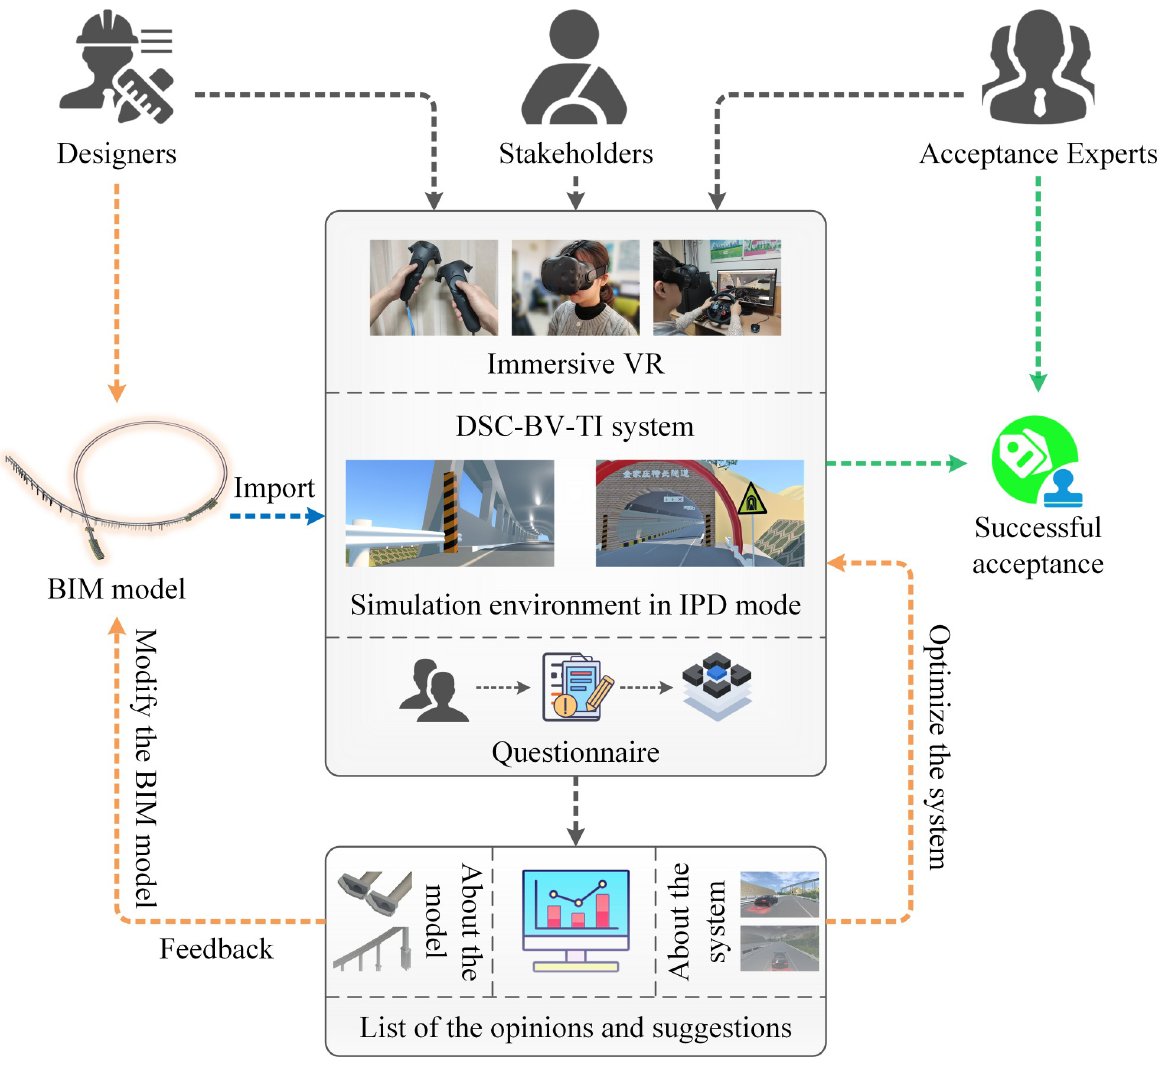
Fig 1. Implementation framework of IPD